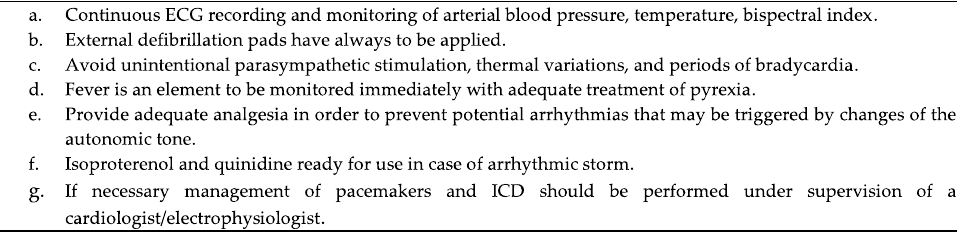
Figure 5. Precautions and general recommendations during ICU management of patients with BS and COVID-19 Infection, modified from Dendramis and Brugada, 2020 [8].